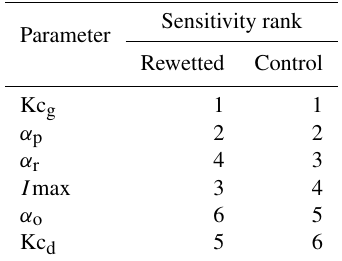
Table 3. Calibrated parameters and efficiency criteria for the differ- ent periods of calibration and validation. Ranges of parameters used for autocalibration are also indicated.